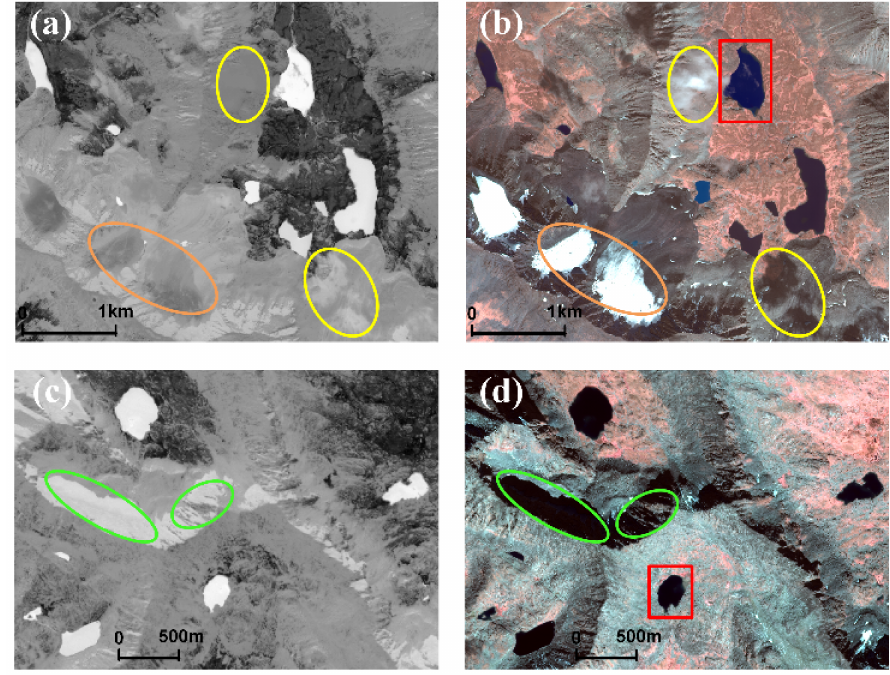
Figure 5. Normalized difference water indices (NDWI) images of glacial lakes and surrounding land cover for regions ( a , c ). ( b , d ) are corresponding false color composite (FCCs) of GF-2 images. Yellow ellipses mark clouds and cloud shadows that do not cover much lake area. The orange ellipse marks glaciers where there was little moisture in the surroundings; these have a distinct spectral signature. Green ellipses mark areas that had a similar response to the glacial lakes; mountain shadows can be seen at the back of the hillsides. The two red rectangles mark typical examples of spectrally heterogeneous glacial lakes that were used for the further investigation described in Section